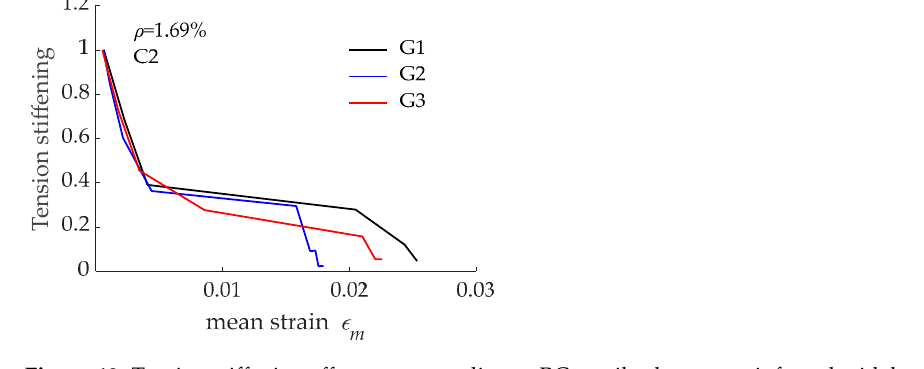
Figure 12. Tension stiffening effect corresponding to RC tensile elements reinforced with bars G1, G2, and G3 and concrete C2.